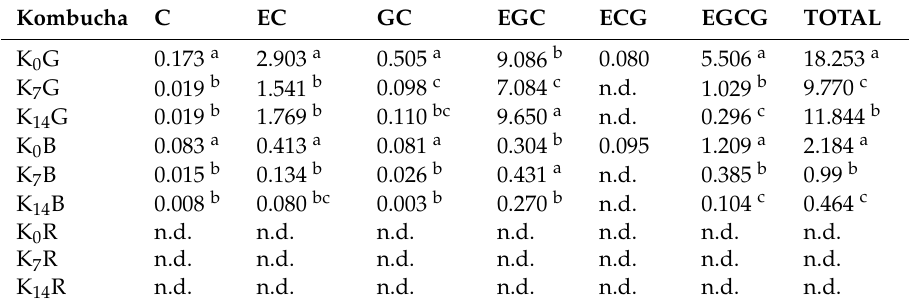
Table 7. Content of catechins in kombucha samples expressed as mg/g DW ± s.d.